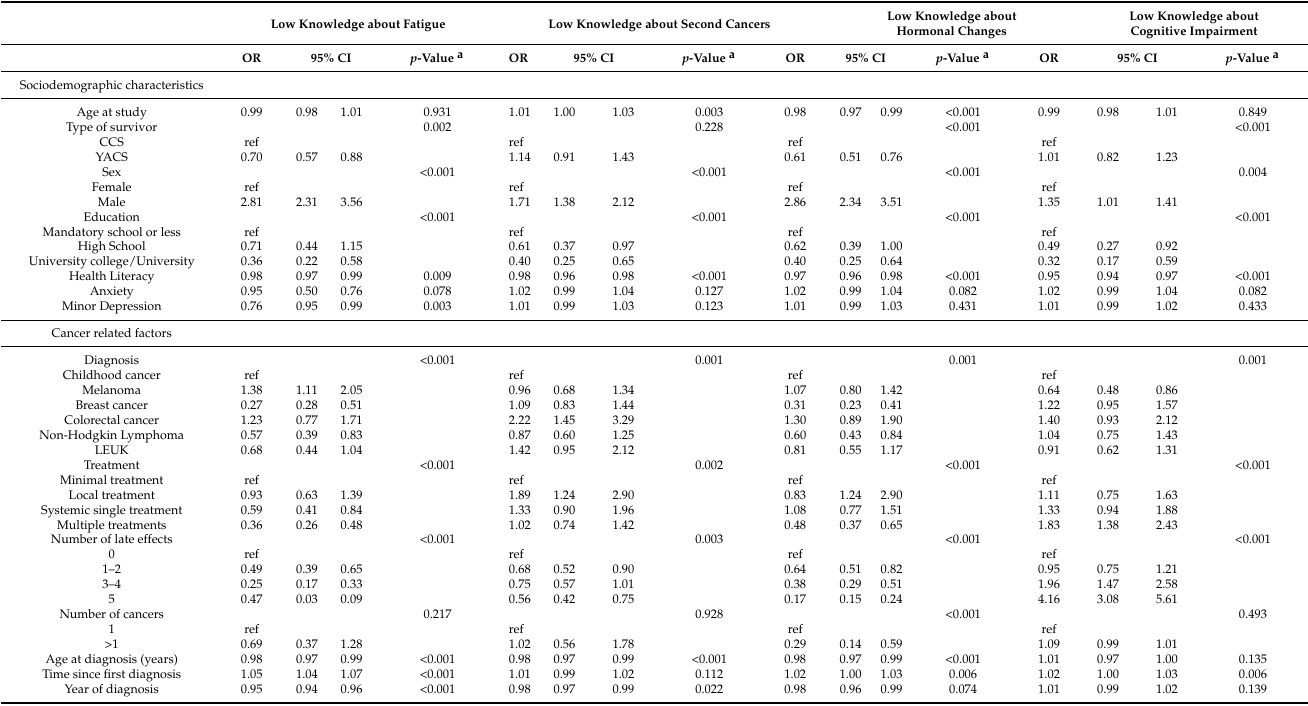
Table 3. Factors associated with low knowledge about different late effects from univariable logistic regression models (n = 1911).